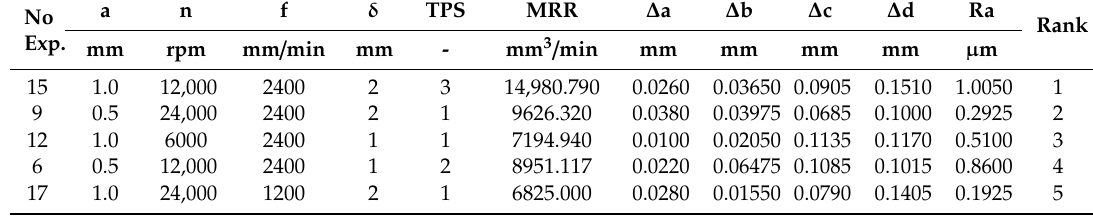
The optimal alternative levels of the high-speed process parameters for line-type thin-walled parts.